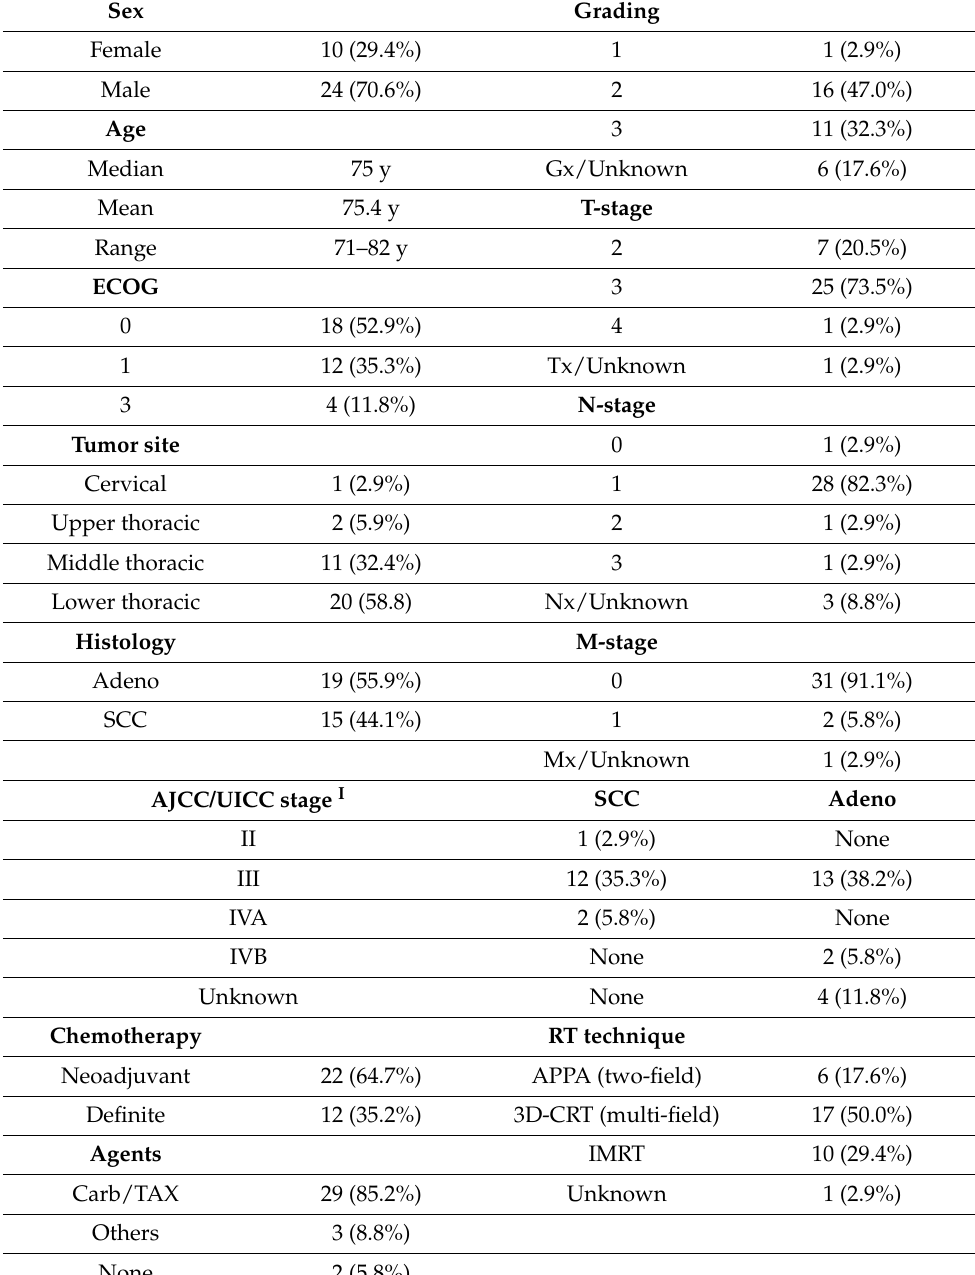
Table 1. Patient and treatment characteristics